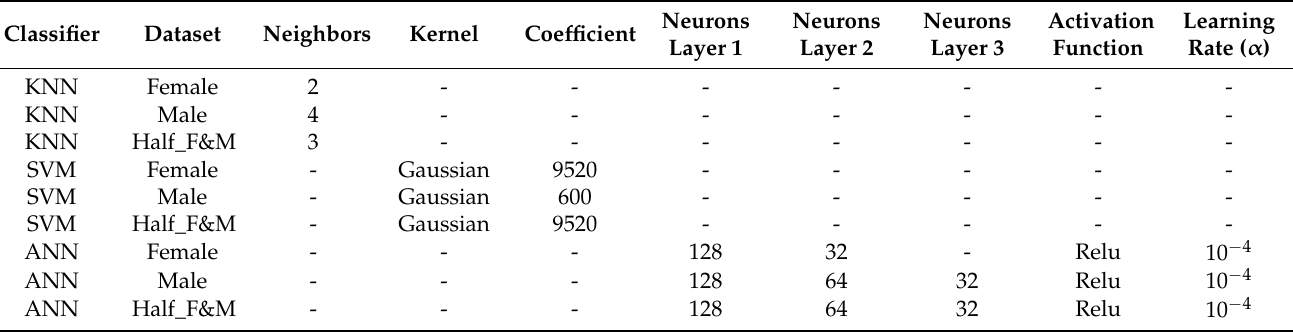
Table 3. The optimal configurations of k-NN, SVM and ANN classifiers for differentiating sex datasets obtained from the training set.